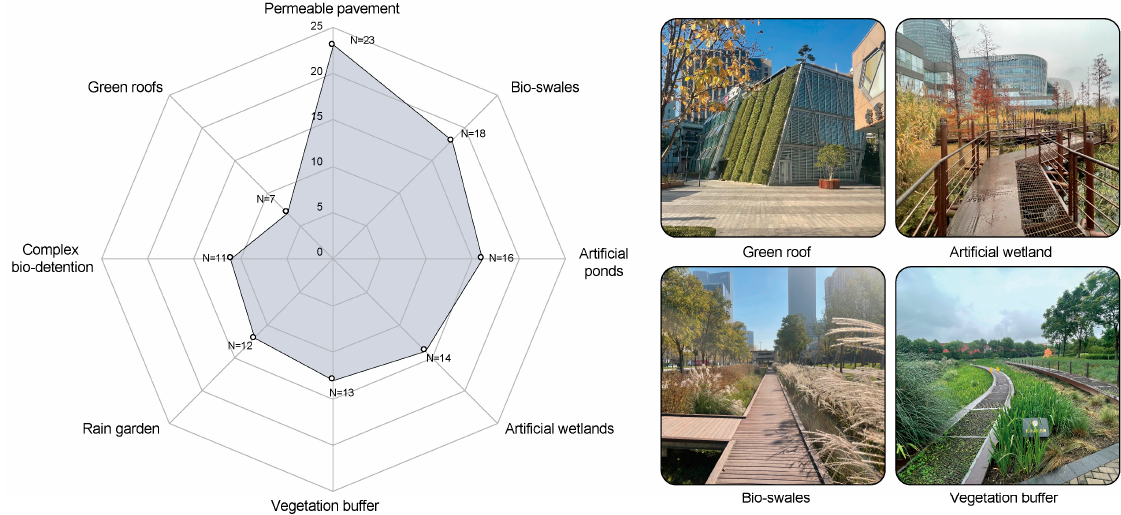
Figure 2. The configurations of applied stormwater